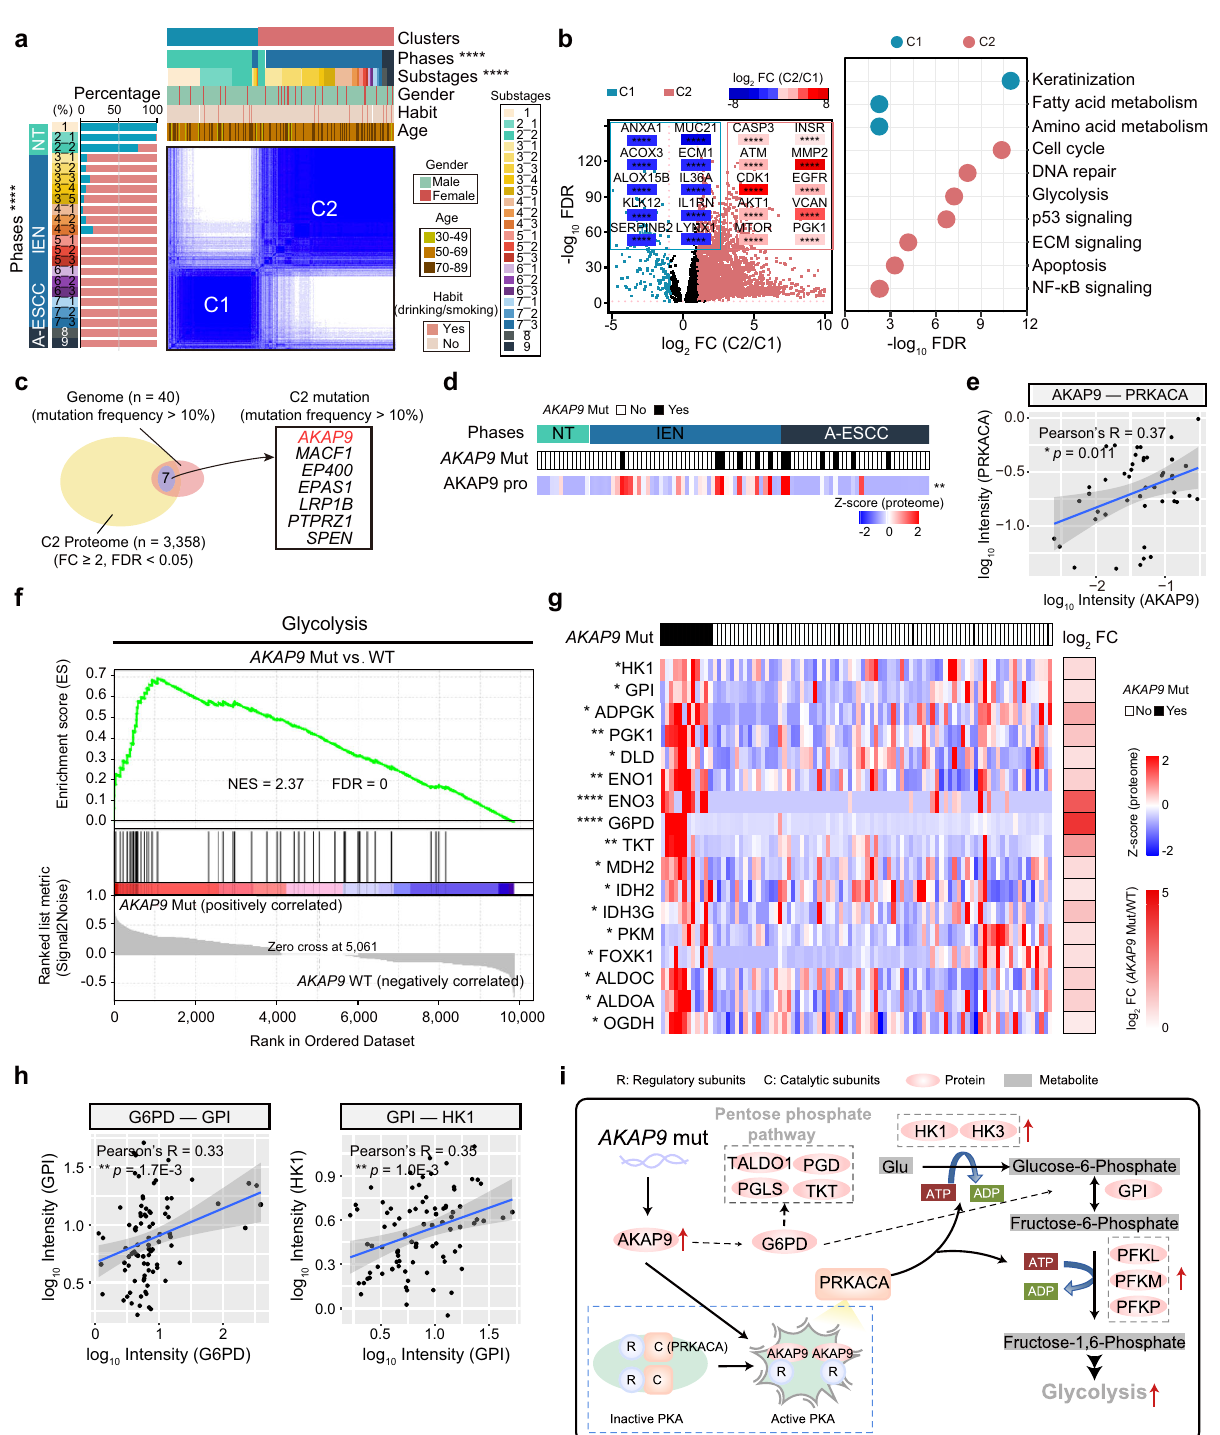
Fig. 5 | Proteomic clusters and the impacts of AKAP9 mutation in ESCC pro- gression. a Consensus clustering analysisof786samples (two-sided Fisher ’ s exact test). Left: the percentages of the two clusters in 22 substages; Right: 786 samples were classi fi ed into two clusters based on proteomic patterns. * p =0.029 (Age), **** p <2.2E – 16(Phases),**** p <2.2E – 16(Substages). b VolcanoanalysisofDEPs(left) in the two clusters and their associated biological pathways (right) in the two clusters (two-sided Student ’ s t -test). Biological pathways were analyzed from the Reactome database. C1: the Cluster 1. C2: Cluster 2. c Venn diagram depicting the number of the genes both detected in the genome and proteome in C2. The right shows the signi fi cant C2 mutations with mutation frequency over 10%. d Heatmap showing the impacts of AKAP9 mutation on the protein level of AKAP9 (two-sided